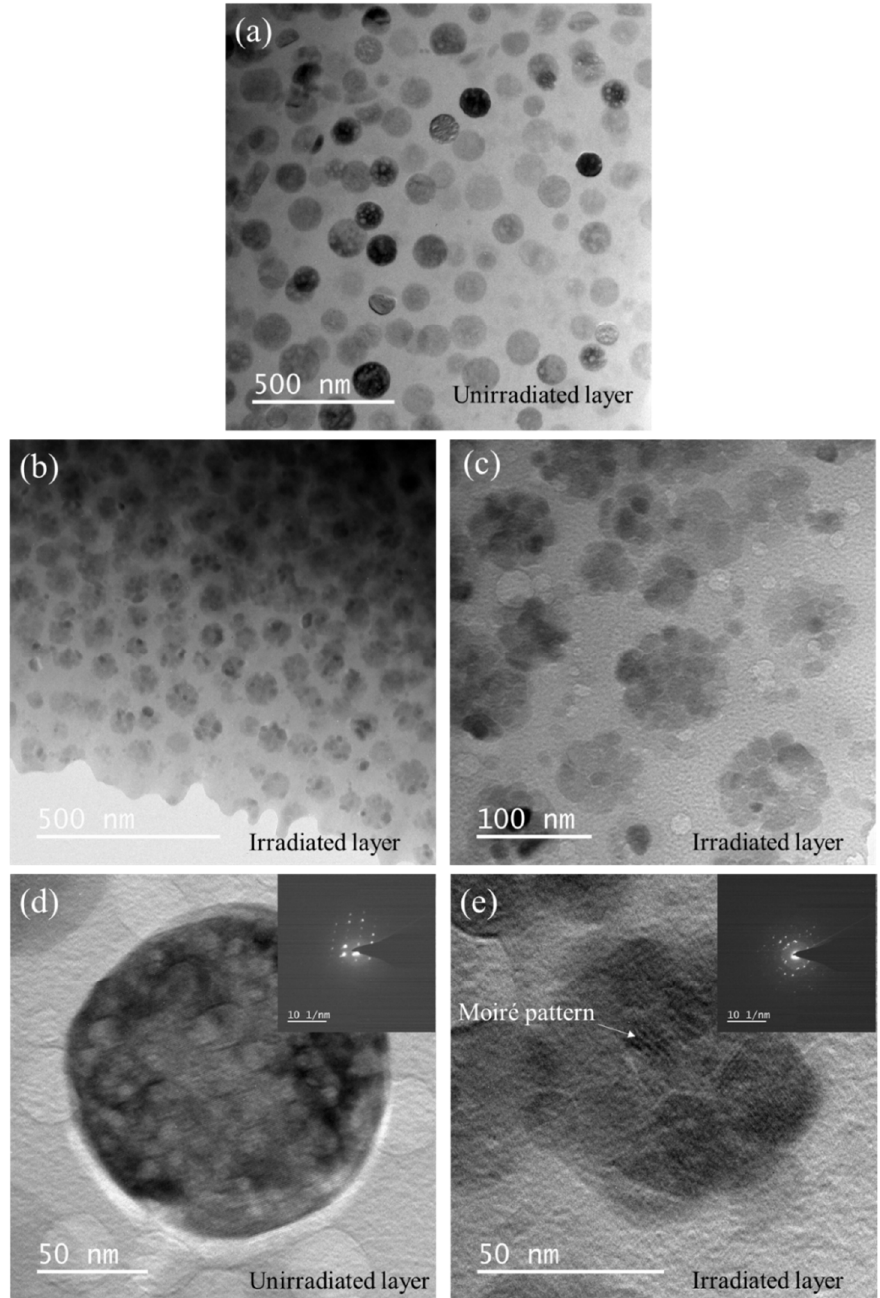
Figure 5. XTEM micrographs of GC2 sample before and after He + ion irradiation. ( a ) Unirradiated layer, ( b , c ) irradiated layer, ( d , e ) enlarged view with corresponding Selected Area Electron Diffraction (SAED) of unirradiated layer and Irradiated layer, respectively.